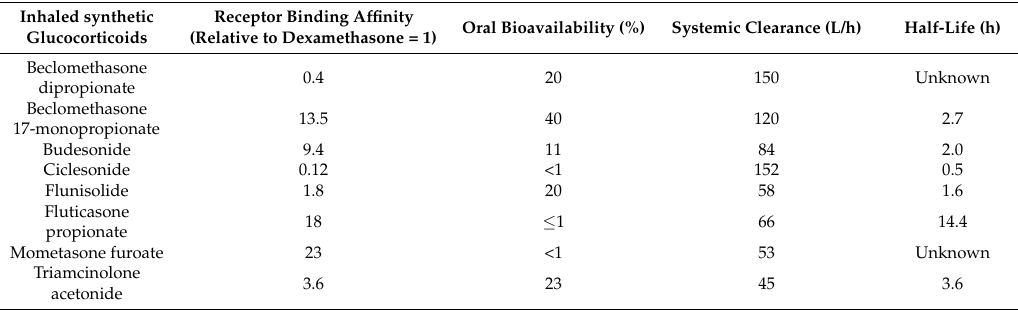
Table 2. Inhaled synthetic glucocorticoids